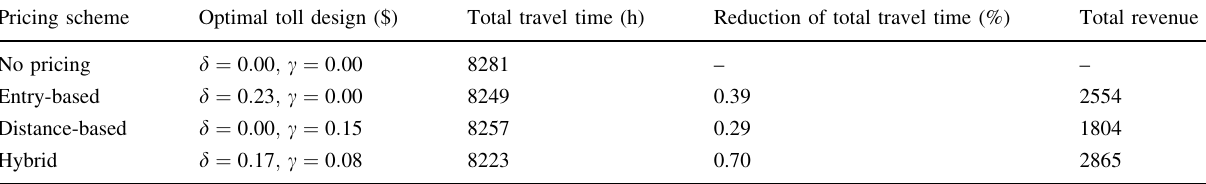
Table 4 Optimal designs of cordon pricing schemes for Sioux Falls Pricing scheme